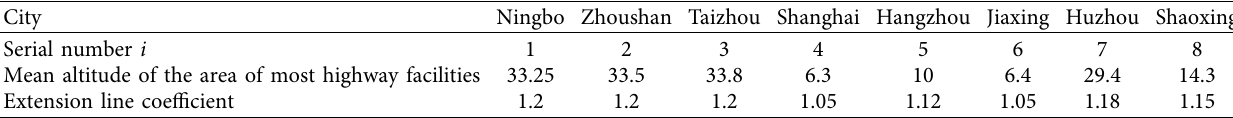
Table 4: Mean altitudes of main roads in the eight cities (unit: m).